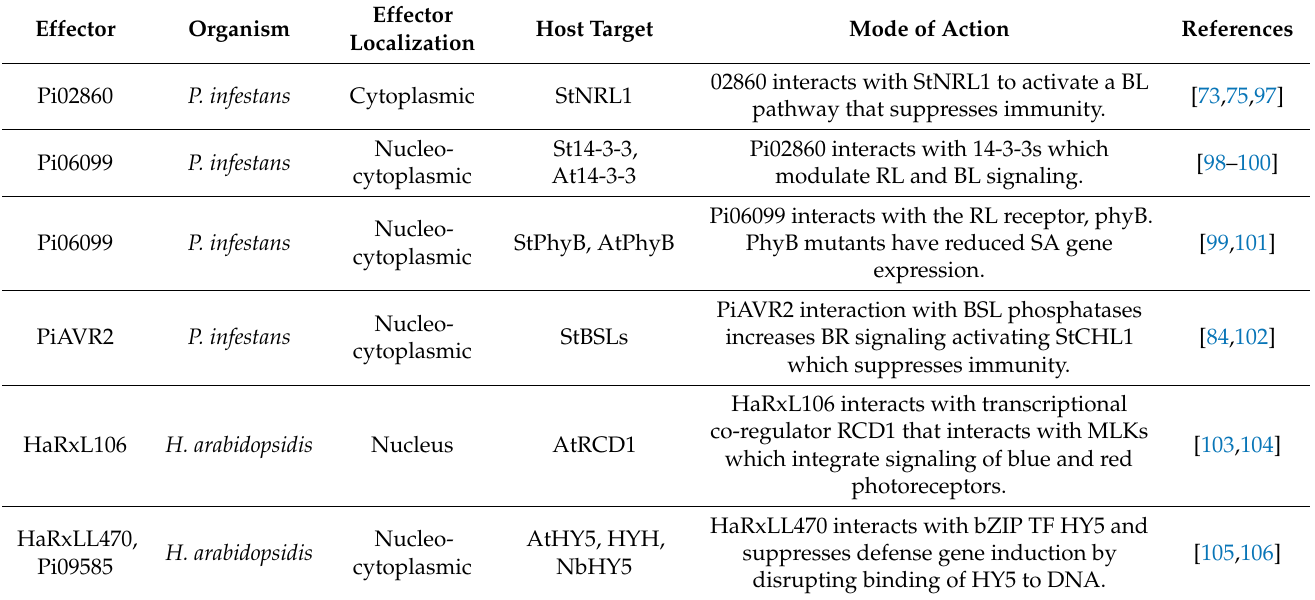
Figure 2. Effector modes of action diagram. Diagram of a plant cell showing the modes of action of various pathogen effector proteins (yellow). Signaling components of red or blue light signaling are shown in red or blue, respectively. Shared components are shaded red and blue. Proteins with a chloroplast function are shown in green. Components of the proteasome are indicated in grey. Interactions that remain to be fully characterized are indicated by “?”. Table 1. Effectors targeting light signaling pathways and inhibition of protein translocation into the chloroplasts.